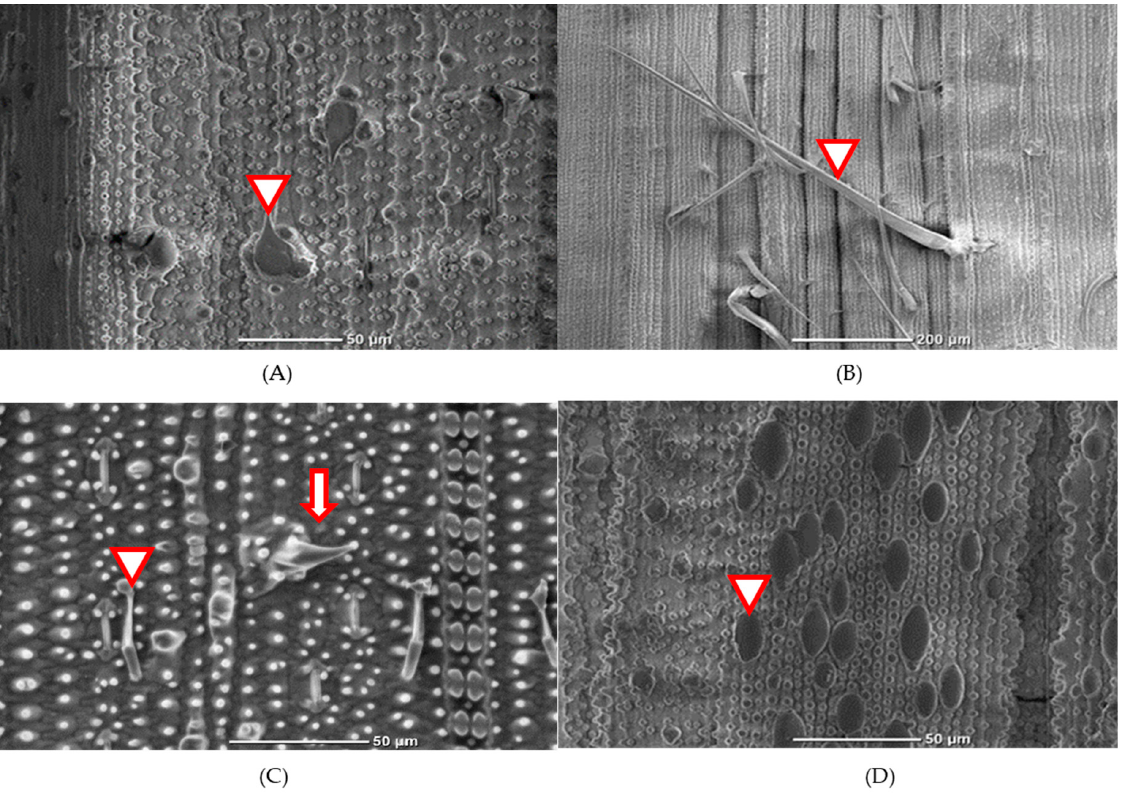
Figure 1. The scanning electron microscopy (SEM) observation of rice leaf surface at 500× magnification. Rice trichomes found in selected varieties were classified as follows ( A ) arrowhead : prickle trichome; ( B ) arrowhead : macro trichome; ( C ) arrow : micro trichome; arrowhead : glandular trichome; and ( D ) arrowhead : Papillae.